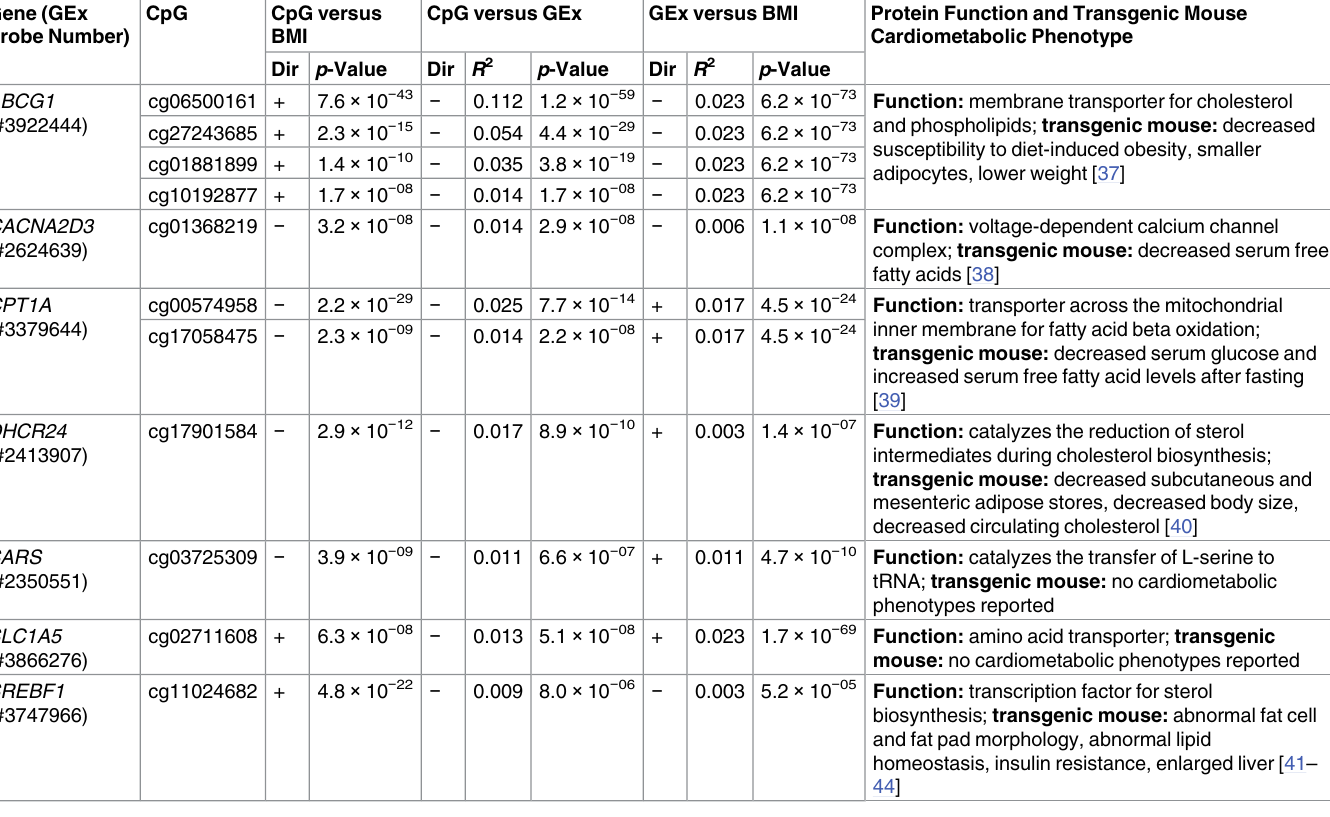
Complete list of results for all methylome-wide significant CpGs is availablein S8